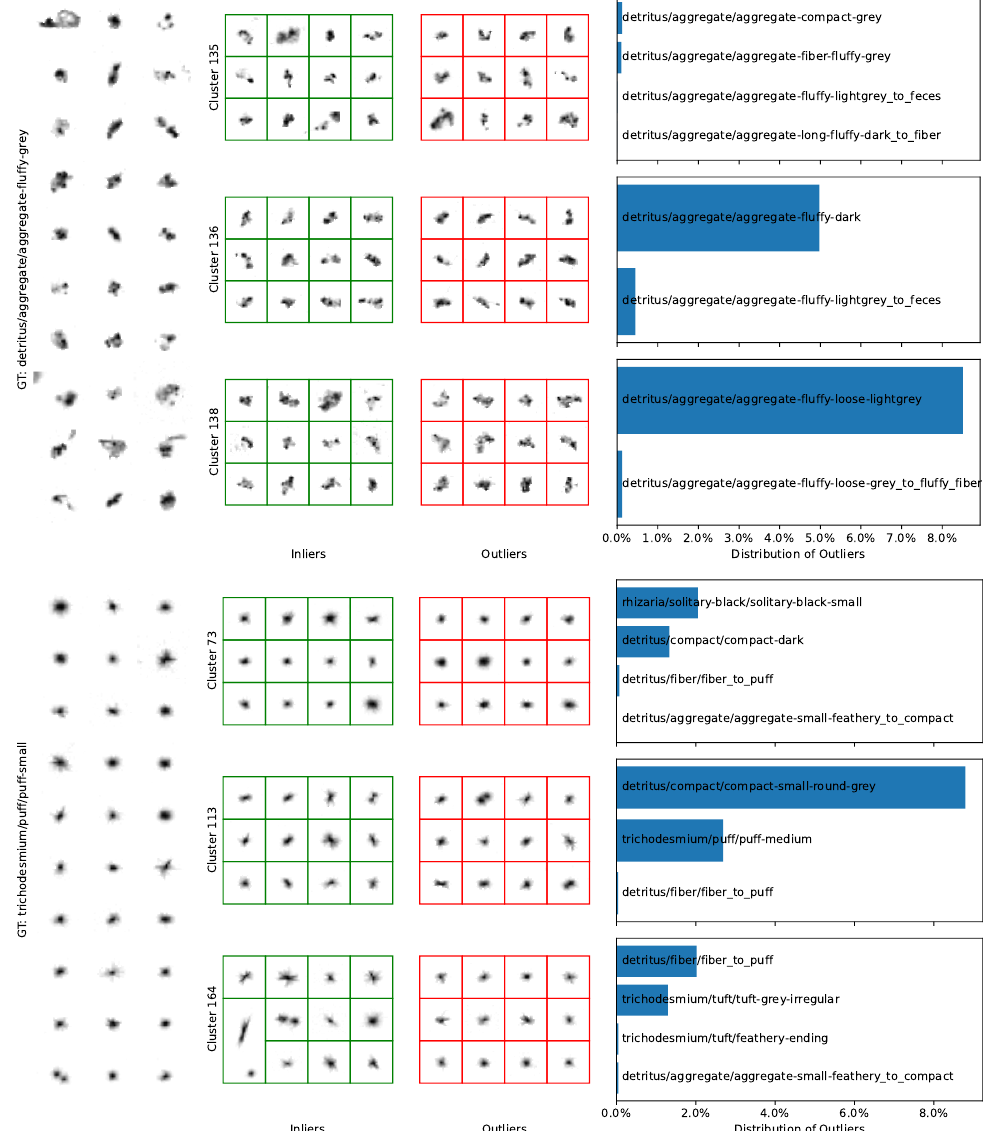
Figure A10. Inliers and outliers for two gold standard classes of the UVP5/MorphoCluster dataset after being assigned to clusters. The outliers are visually very similar to the inliers in the respective cluster and the outlier labels are plausibly close to the respective gold standard